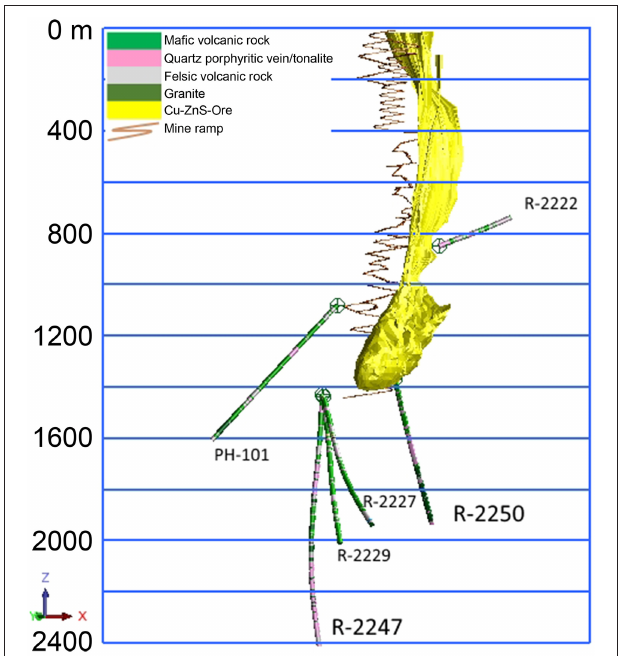
FIGURE 1 | Locations and under ground surface level depths (m) of the studied drill holes and the Pyhäsalmi ore in yellow.